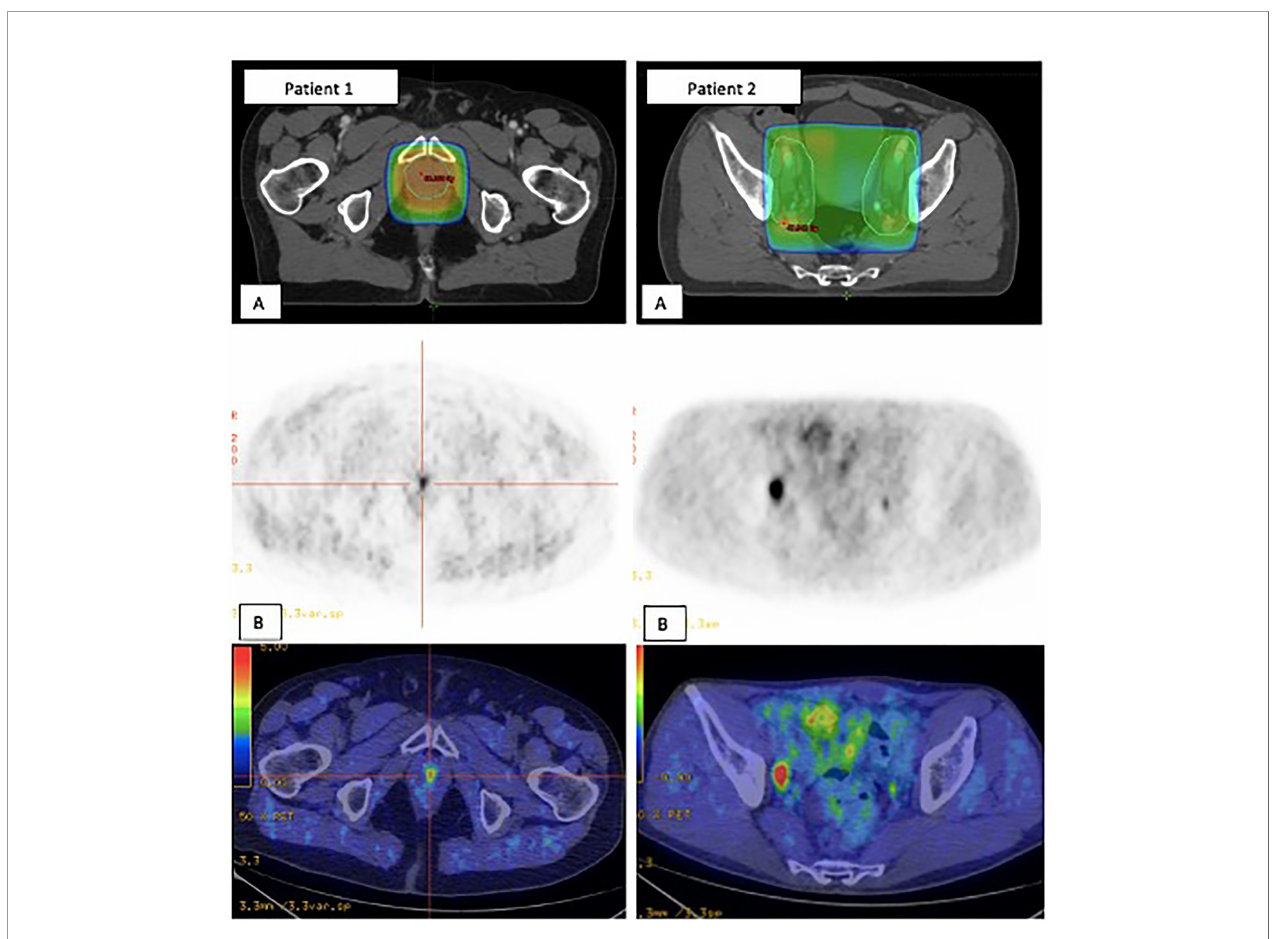
FIGURE 4 | Two patients ’ examples of in- fi eld recurrences (A) which were positive on Choline PET/CT (B) . Patient 1. Urethral anastomosis failure within the PB RT volume. Patient 2. Right iliac extern nodal failure within PLN RT volume. PB, Prostate bed; PET-CT, Positron emission tomography-computed tomography; PLN, Pelvic lymph nodes; RT,